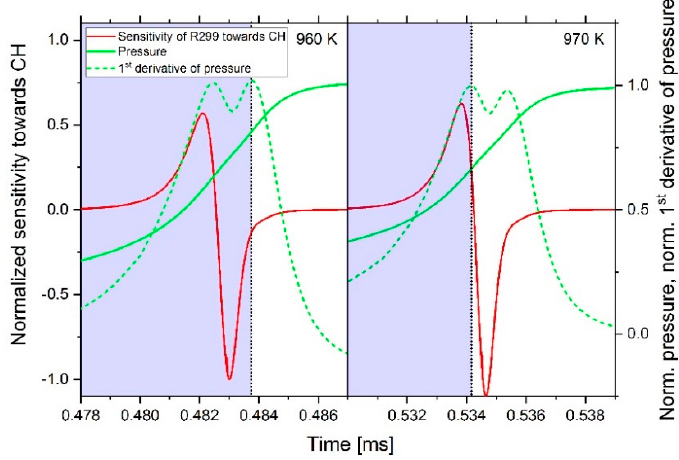
Figure 17. Time-dependent sensitivity towards CH of reaction 299 from Table 2 and the pressure curve simulated with an n -heptane–air mixture at φ = 0.5, start pressure of 60 bar and a start temperature of 960 K (left) and 970 K (right).